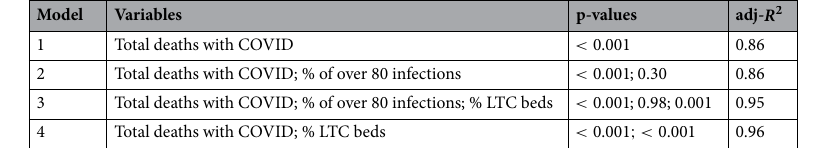
2 are reported for each